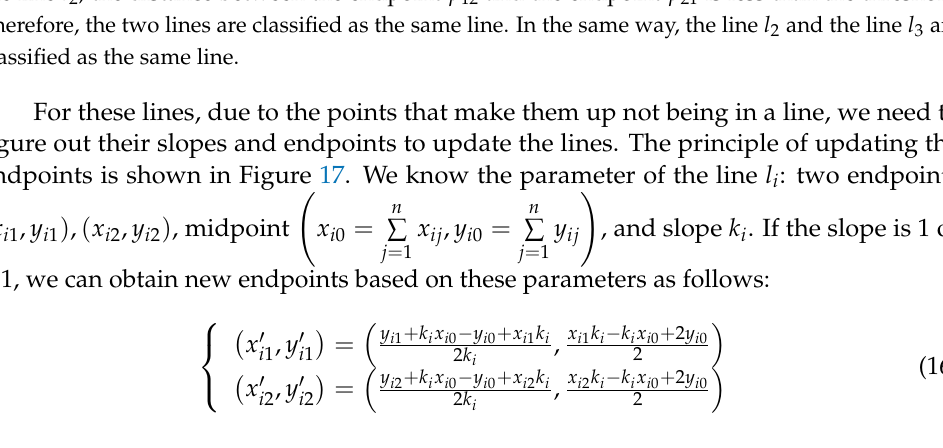
l : two endpoints l : two endpoints i i